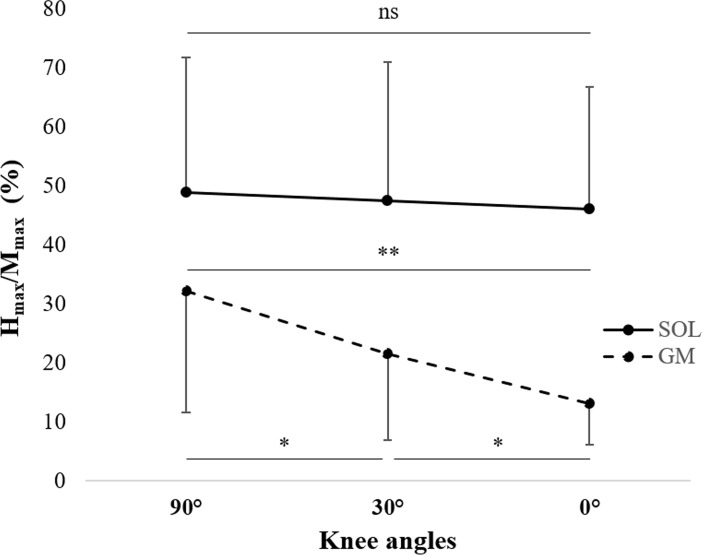
Effect of the knee angle on the soleus (SOL, continuous lines) and gastrocnemius medialis (GM, dotted lines) Hmax/Mmax.ns: no statistical difference. * P<0.05, ** P<0.01.